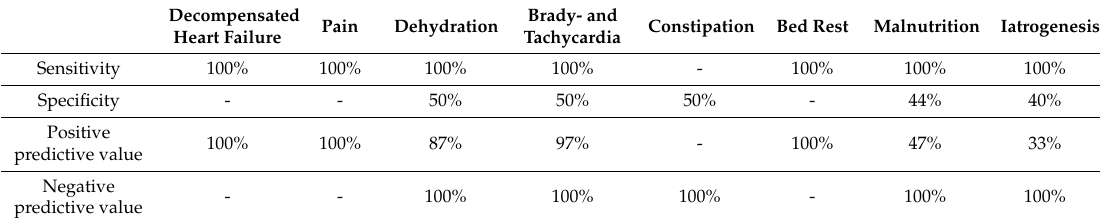
Table 9. Sensitivity, specificity, and positive and negative predictive values for alerts from the MyPredi ™ remote monitoring platform.